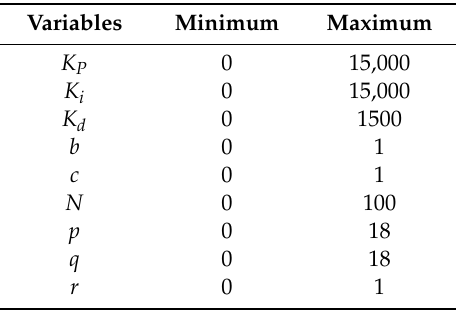
Table 2. Ranges of the variables.